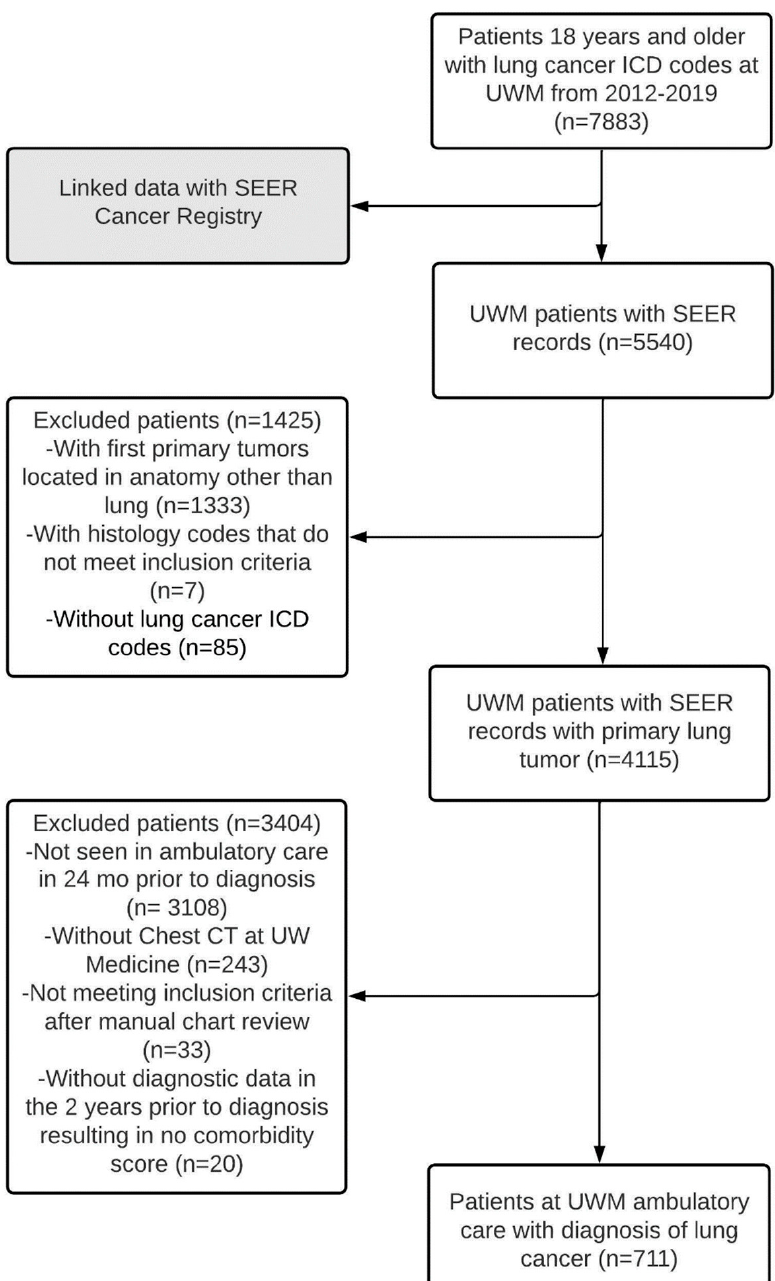
Figure 1. Flow chart of selection of patients with lung cancer.